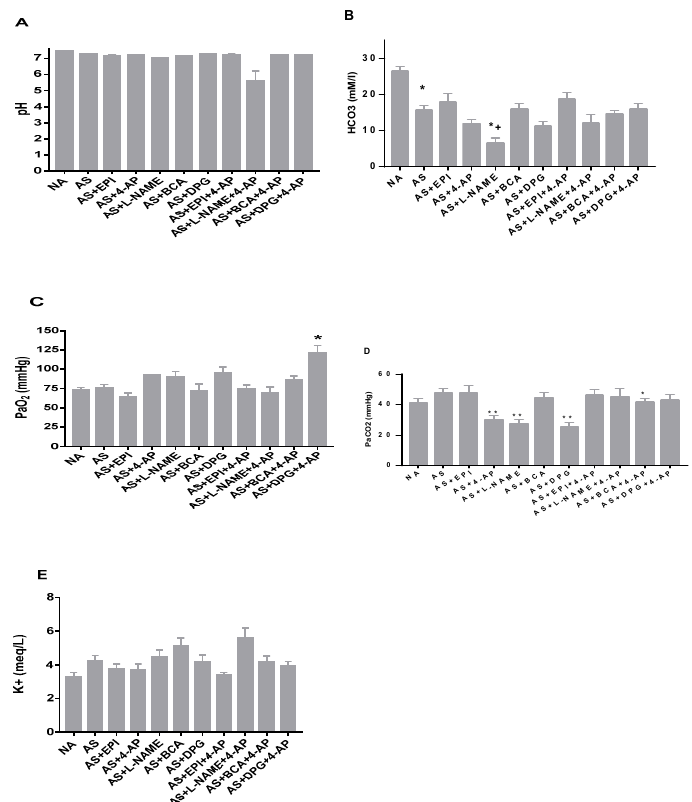
Figure 3. Arterial blood levels of pH ( A ), [HCO3–] ( B ), pO2 ( C ), pCO2 ( D ) and [K+] ( E ) after injection of ovalbumin in non-allergic (NA), allergic rats (AS), and rats treated with L-NAME, DPG, BCA, 4-AP or EPI, and rats treated with the 4-AP drug combinations L-NAME+4-AP, DPG+4-AP, BCA+4-AP, or EPI+4-AP. Values are Mean ± S.E.M; * p < 0.05 vs. AS group, ** p < 0,001 vs. AS group,+ p < 0.05 vs. EPI group, ≠ p < 0.05 vs. 4-AP group. NA, non-allergic rats; AS, allergic rats; BCA, β -cyanoalanine; DPG, dl-propargylglycine; L-NAME, L-NG-Nitroarginine methyl ester; 4-AP, 4-aminopyridine; EPI, epinephrine. BCA+4-AP, β -cyanoalanine+4-aminopyridine; DPG+4-AP, dl-propargylglycine+4-aminopyridine; L-NAME+4-AP, L-NG-Nitroarginine methyl ester+4-aminopyridine; EPI+4-AP, epinephrine+4-aminopyridine.